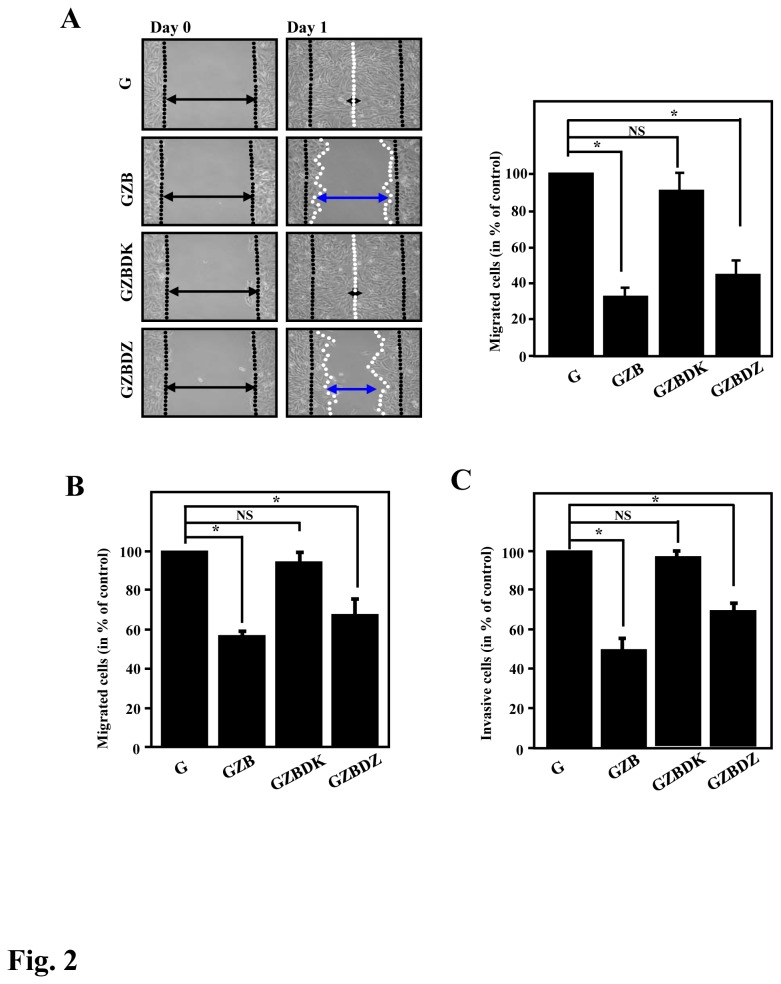
The KRAB domain of ZBRK1 is essential for the inhibition of cell migration and invasion.
A, Left, a wound-healing migration assay was performed with HeLa cells expressing EGFP (G), EGFP-ZBRK1 (GZB) or mutated ZBRK1 (GZBDK or GZBDZ). Representative images of the wound sealing were collected on the day of the laceration and the day after the wound scratch. Right, the level of cell migration into the wound scratch was quantified as the percentage of wound healing. Columns, average of three independent measurements; bars, mean ± SD. *p<0.05. B, HeLa cells expressing GZBDK relieves the cell migration inhibitory ability. The cells were seeded in transwells, and the level of cell migration was determined. C, HeLa cells expressing GZBDK relieves the cell invasion inhibitory effect. The cells were seeded in a BD matrix gel layer, and the level of cell invasion was determined using CyQUANT NF dye (Invitrogen), as described in the Materials and Methods. The plot displays the statistical results from three independent experiments. Bars, mean ± SD. *p<0.05.